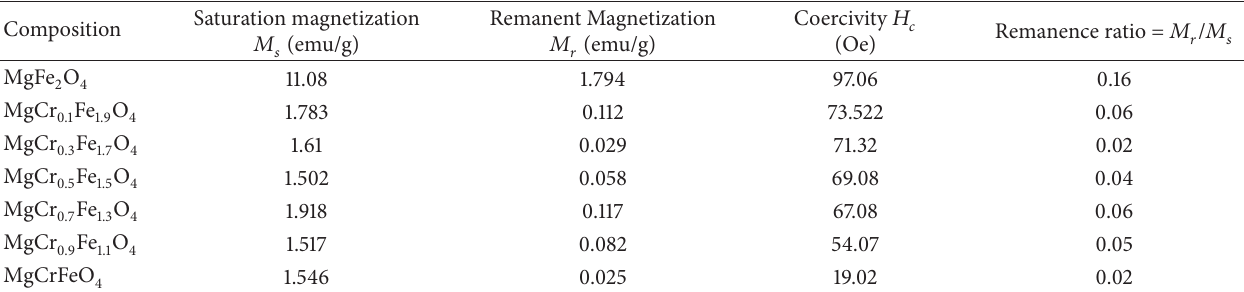
Figure 2: (a) variation of Saturation Magnetization with composition. (b) variation of anisotropy constant with composition. Table 3: Magnetic parameters from Hysteresis